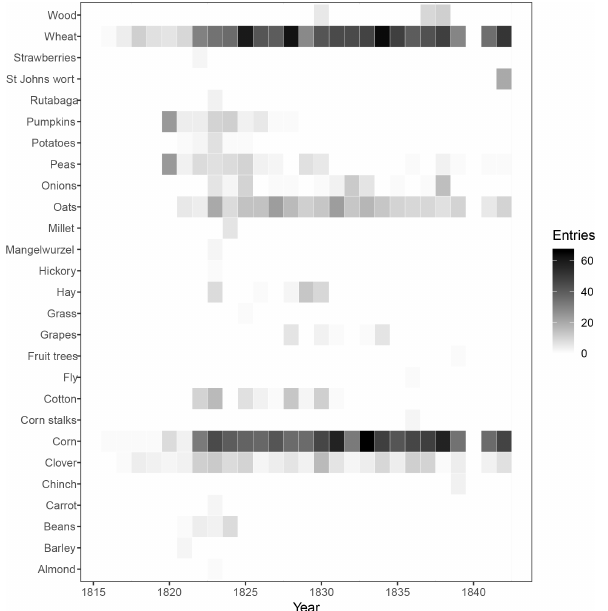
Figure 2. Heat map of species mentioned in the Shirley Plantation document. This heat map shows which years a crop was mentioned and how many times it was mentioned that year.